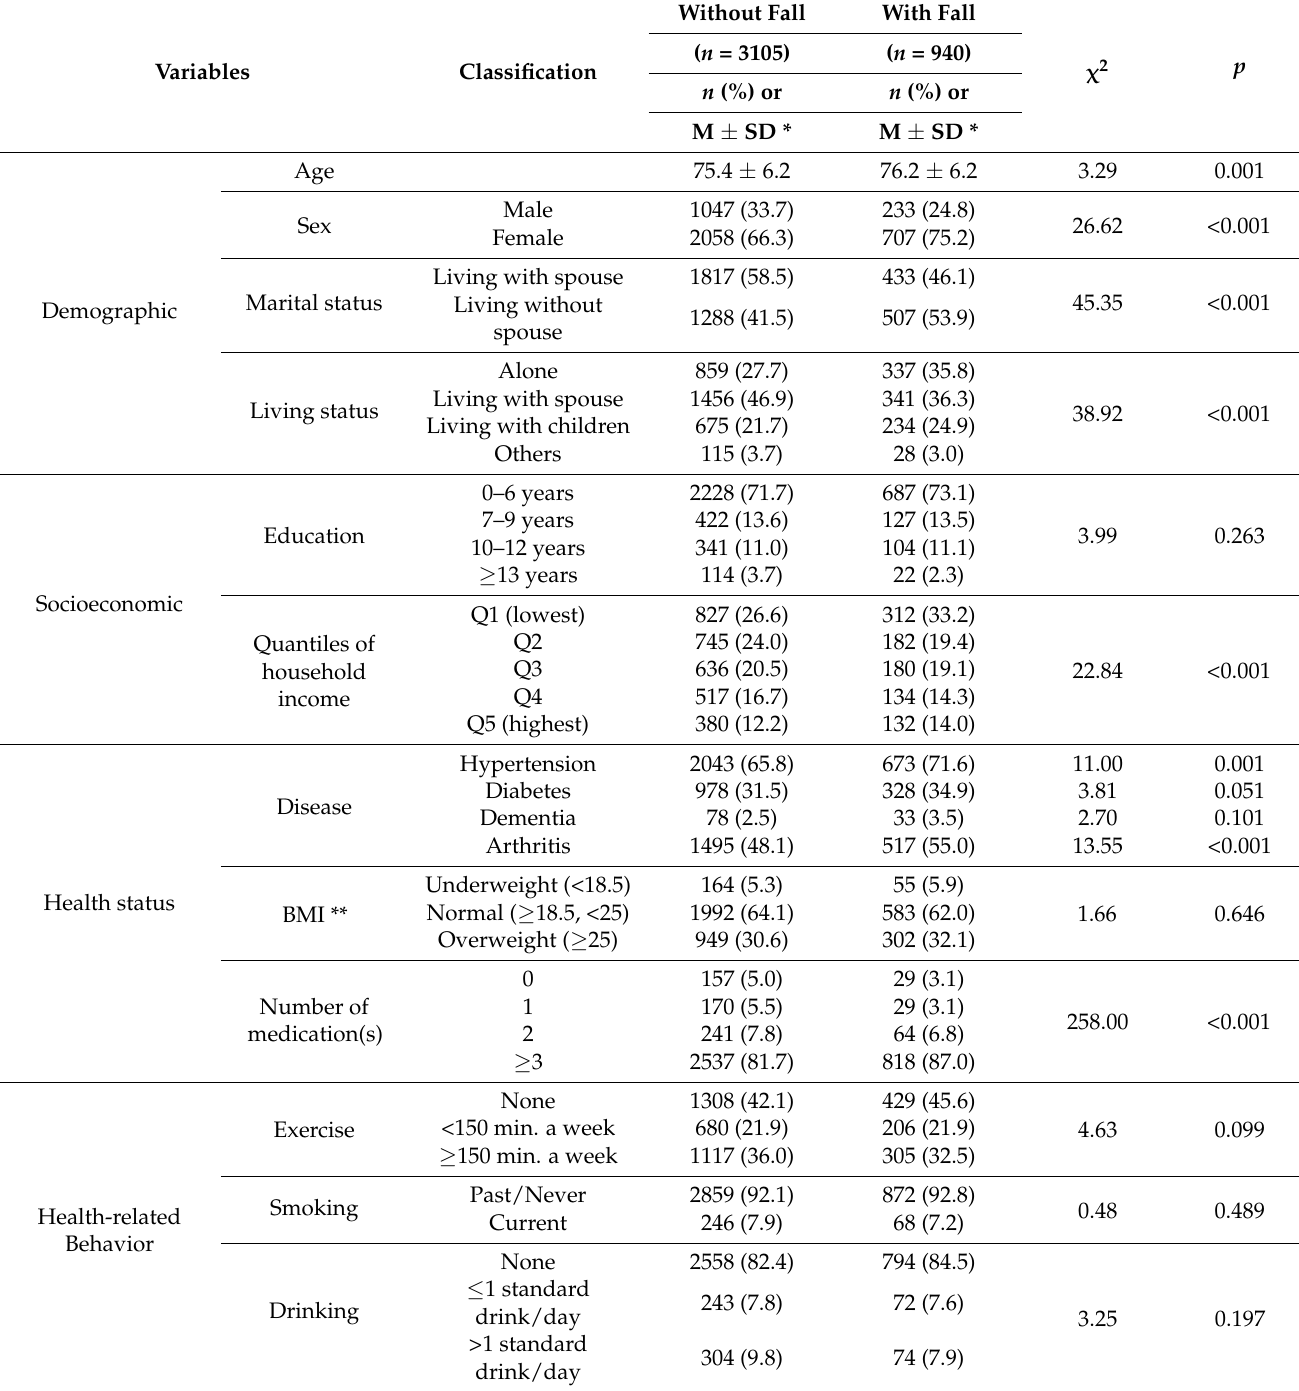
Table 1. Differences in individual variables between groups with and without fall history ( n =